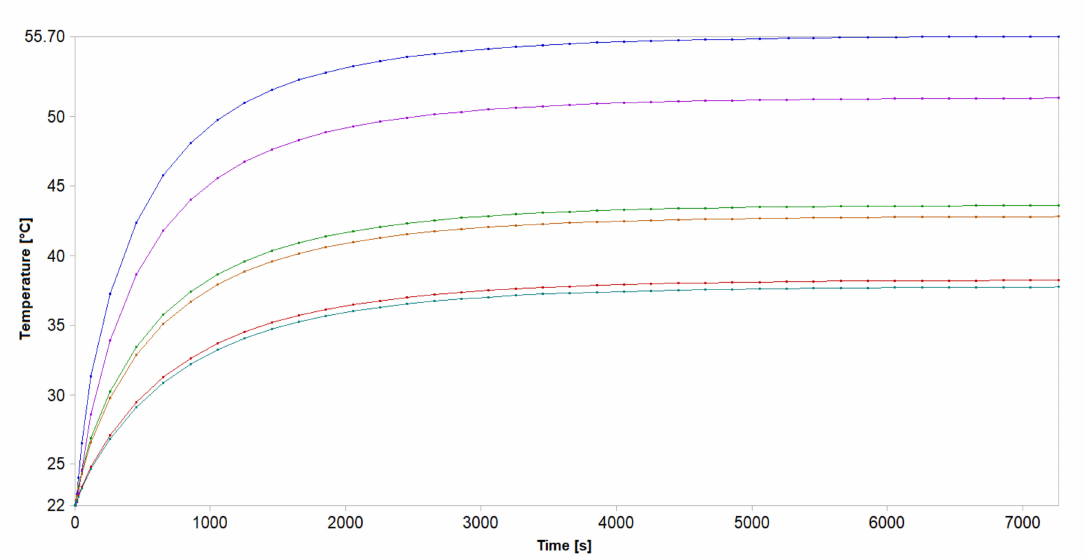
Figure 11. Chart showing results of ANSYS simulations for thermocouples T1; T2; T3; T4; T5 and T6. The results were obtained for a time of 7200 s for a type of fuse NH000 gG 100 A.